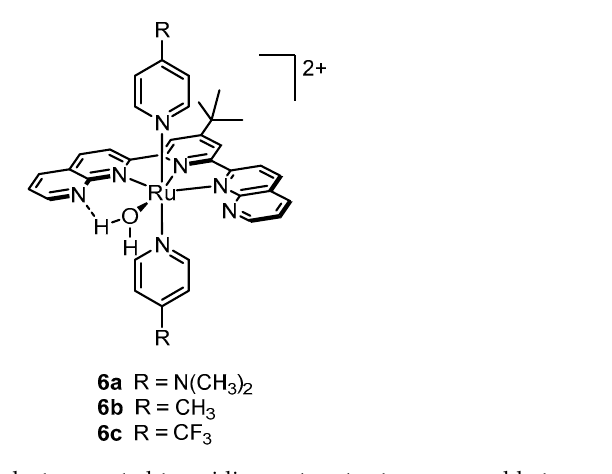
Figure 6. First mononuclear catalysts reported to oxidize water at rates comparable to previously reported dinuclear reported dinuclear systems.